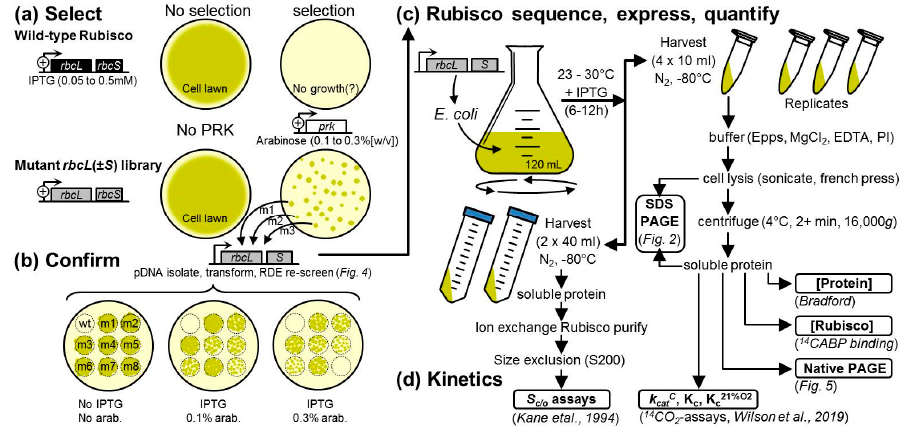
Figure 3. The analytical pipeline of an RDE experiment. An RDE-directed evolution project begins with ( a ) Rubisco gene library generation, transformation and RDE selection. The Rubisco gene plasmid ( rbcl–rbcs ) from cells with improved fitness is ( b ) transformed into fresh RDE cells and re-screened on PRK-inducing arabinose to confirm the improved growth phenotype before ( c ) sequencing to ascertain the amino acid substitutions. Each Rubisco mutant is then expressed in E. coli and the Rubisco subunit folding / assembly capacity evaluated by SDS PAGE (e.g., Figure 2); the L 8 S 8 holoenzyme content is then quantified ( 14 C-CABP binding), confirmed (native PAGE) and ( d ) the kinetics (S C / O , k catC , K C and K C21%O2 ) measured as described in